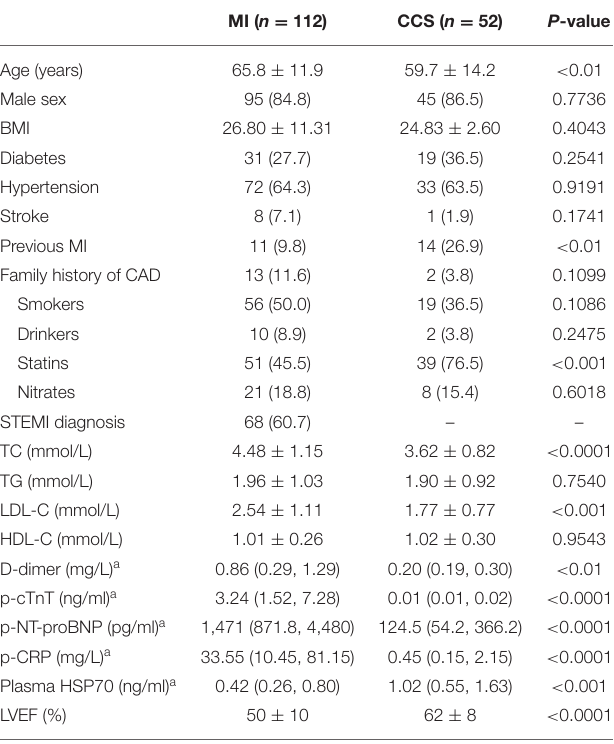
TABLE 1 | Population characteristics of the MI and CCS